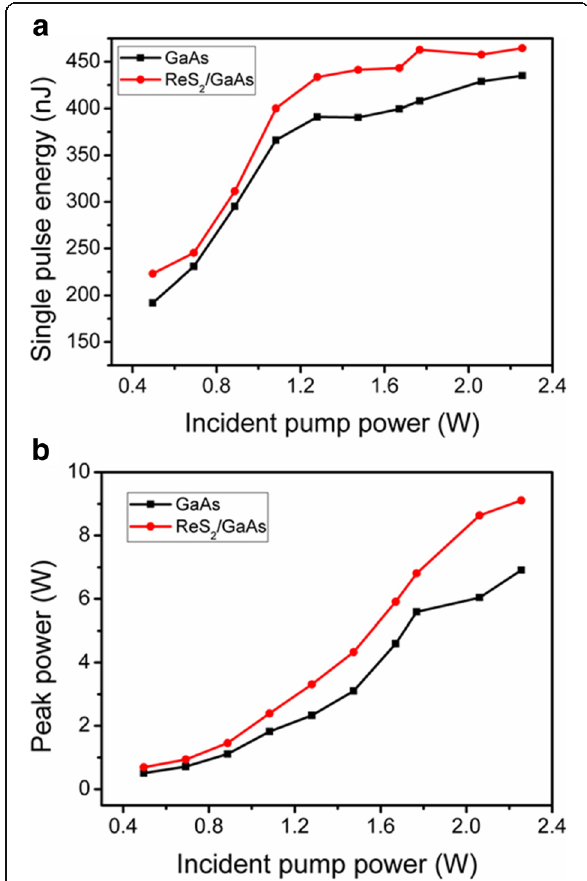
Fig. 7 Pulse energy ( a ) and peak power ( b ) of the Q-switching